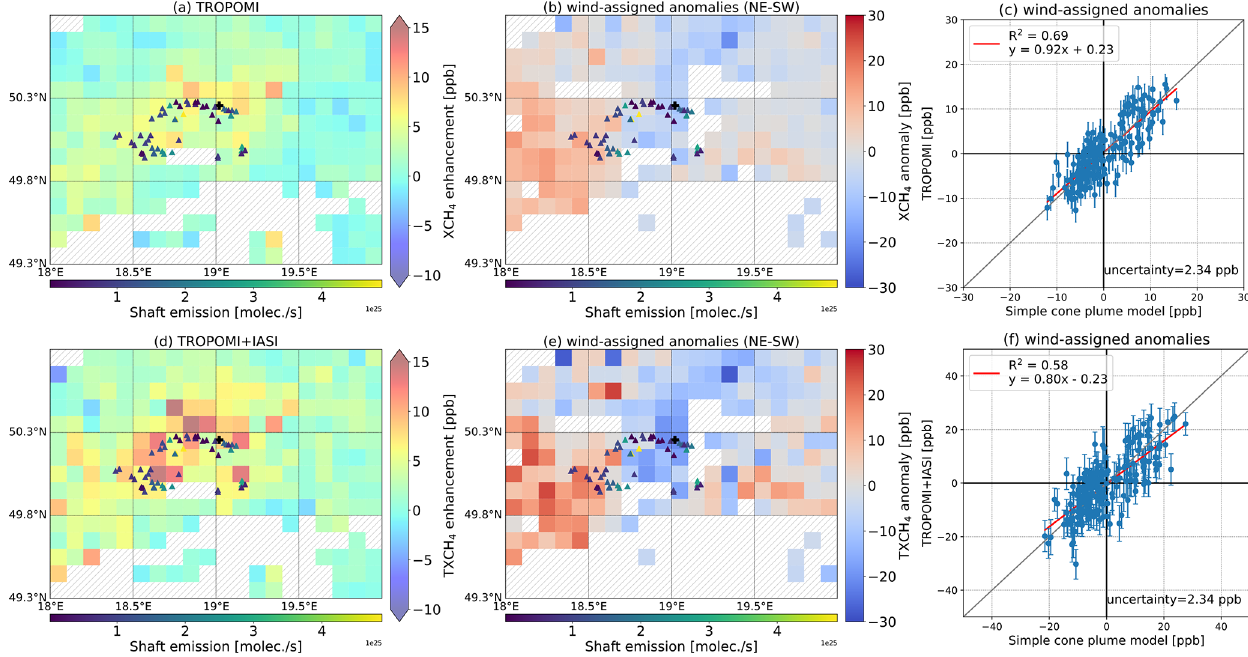
Figure 7. Similar to Fig. 5, but for TROPOMI XCH 4 (a–c) and TROPOMI + IASI TXCH 4 (d–f) . The a priori knowledge of sources are based on the CoMet inventory (6 . 6 × 10 26 molec.s − 1 in total, Gałkowski et al., 2021a). The triangle symbols represent the locations of the active coal mine shafts and different colors denote the amount of emission